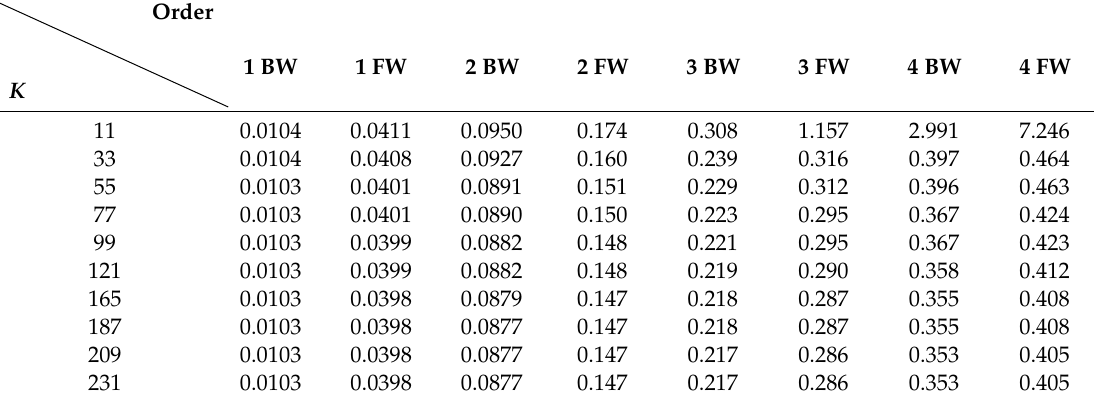
Table 5. Natural frequencies via modal discretization ( h = 400 Nms).